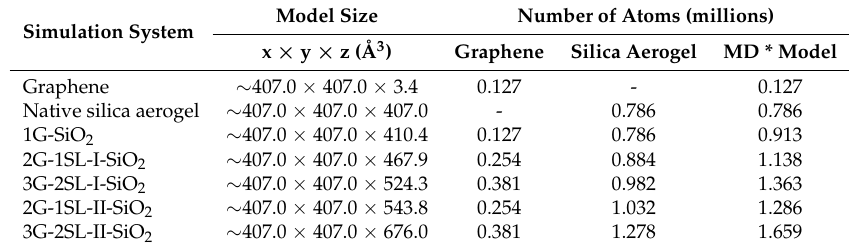
Figure 1. ( a ) Indentation force–depth ( P – h ) curve of the nanoindentation test of a graphene sheet. ( b ) Snapshots of the graphene-indenter system during indentation. The spherical indenter (gray) was moved downwards to fracture the graphene sheet (red). The first two snapshots show the deformation of the graphene before fracture, and the last two show the behavior of graphene after fracture. Table 1. Description of the MD simulation models. G, graphene; SL,